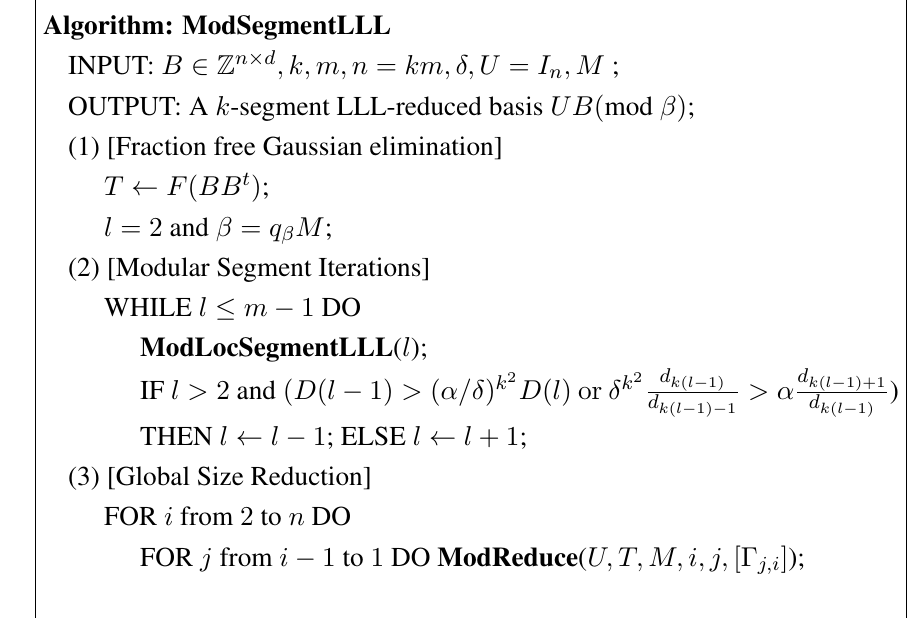
Figure 12. The Modular Segment LLL Basis